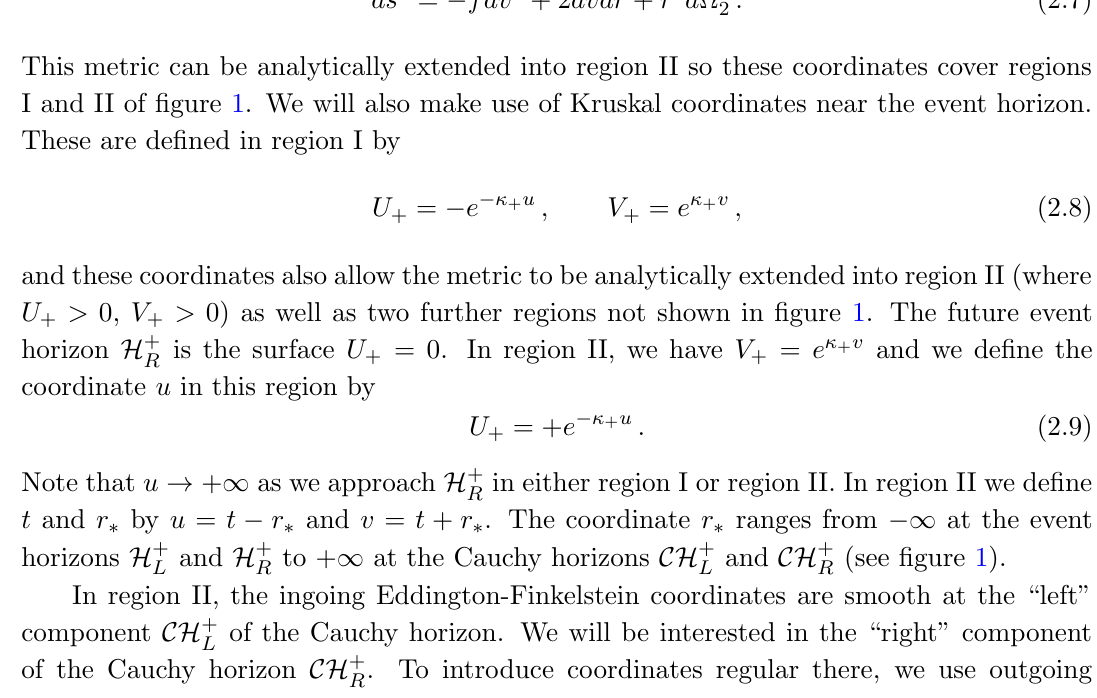
, the future cosmological horizon is H + R